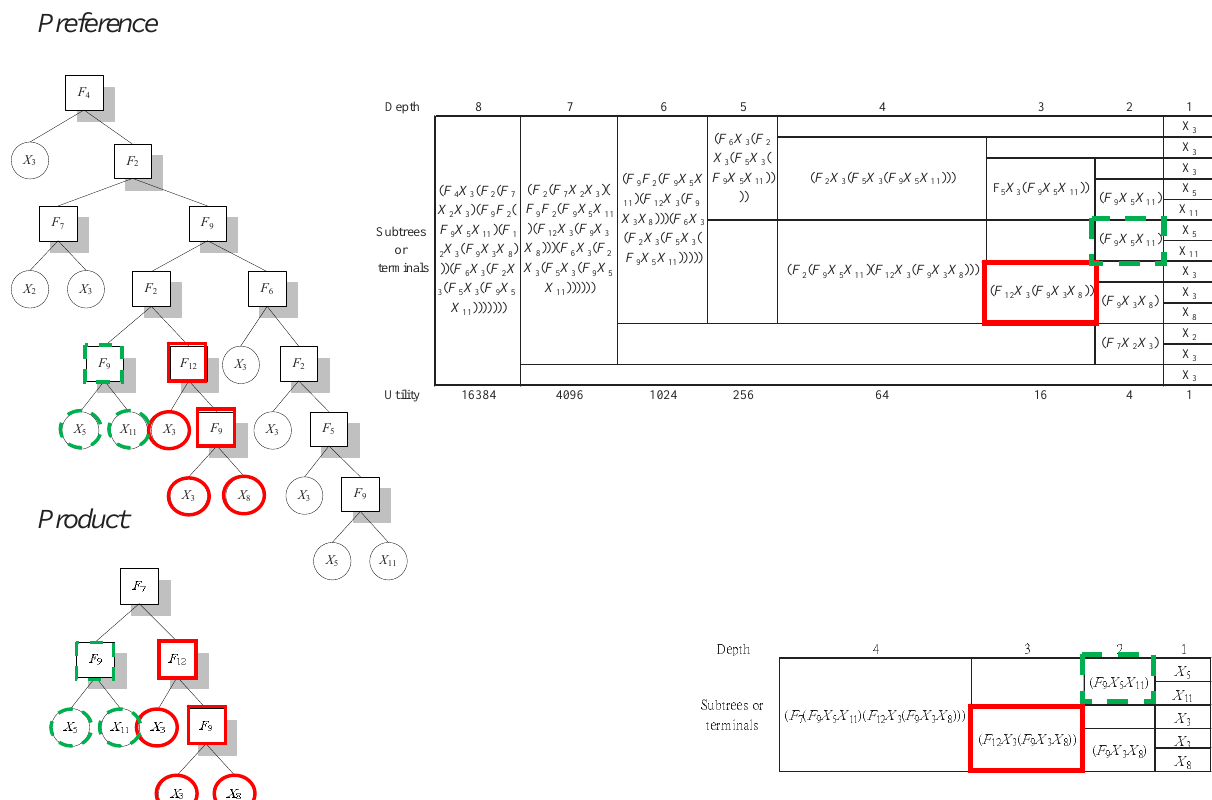
Figure 10. Preference